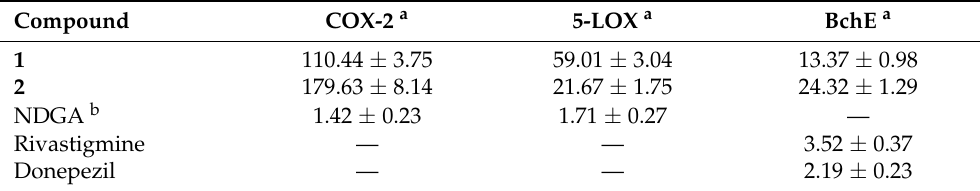
Table 3. IC 50 ( µ g/mL) values of the isolated compounds against COX-2, 5-LOX, and BchE enzymes. Compound